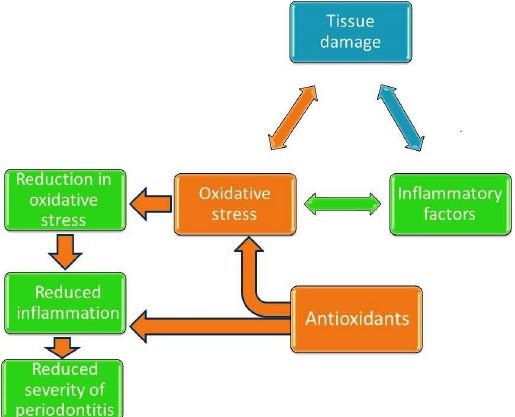
Figure 2. Periodontal disease is a complex process of infective and inflammatory processes leading to production of reactive oxidative species (ROS), which in turn worsen periodontitis. Antioxidants may improve periodontal health and outcomes of periodontal therapy by reducing the oxidative stress via scavenging ROS.